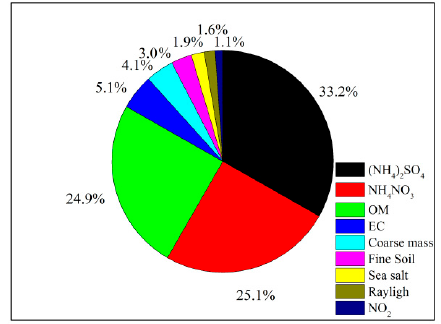
Figure 6. Relative contributions of different components to the light extinction estimated by the IMPROVE formula.